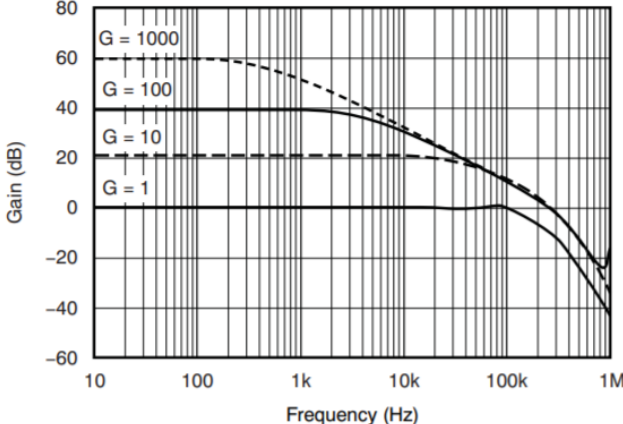
Figure 9. Gain vs. frequency.